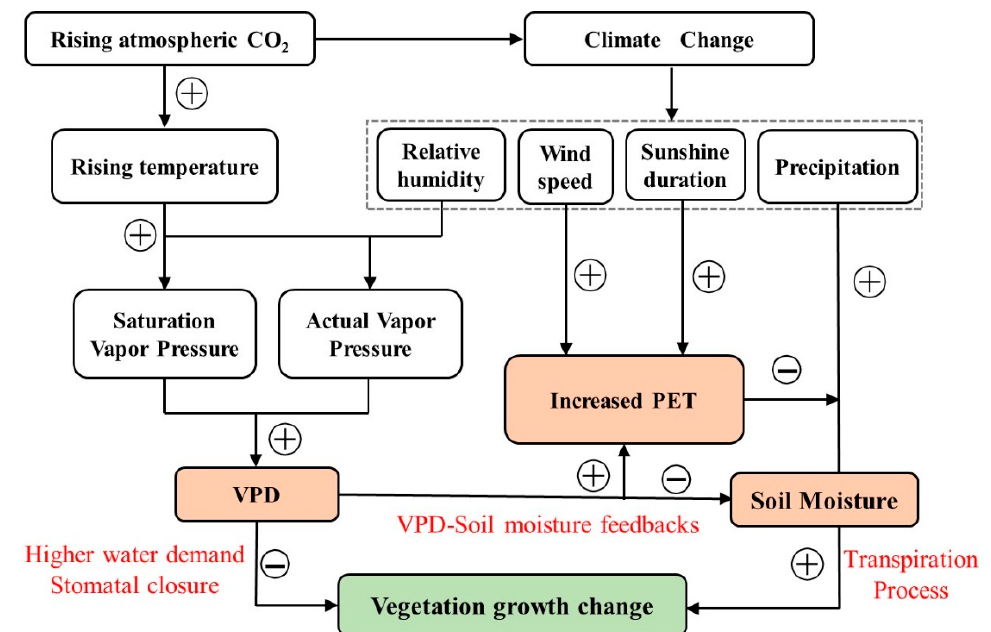
Figure 14. Schematic representation of the impacts of climatic variables on vegetation growth under the effects of increasing levels of atmospheric CO 2 . Circled symbols of ‘ − ’ and ‘+’ represent a negative and positive impact, respectively.